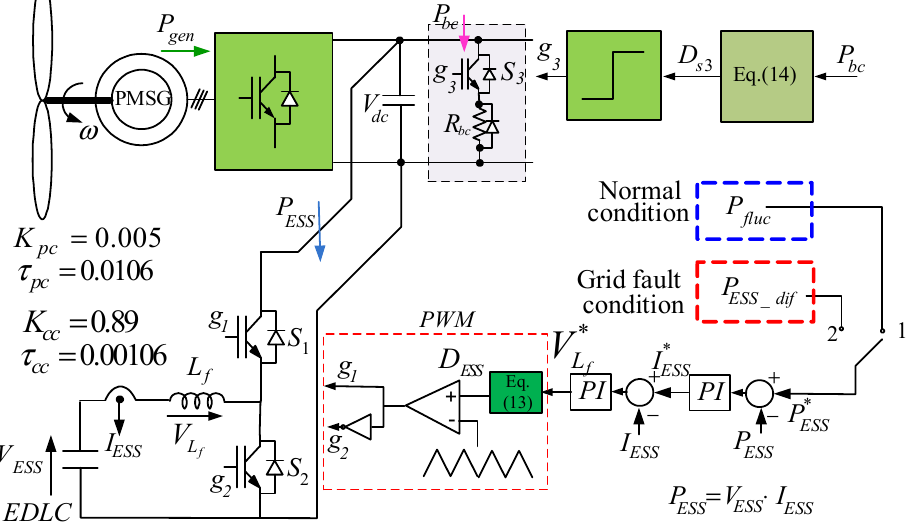
Figure 4. Power and current controllers of the ESSs and the braking chopper operation.